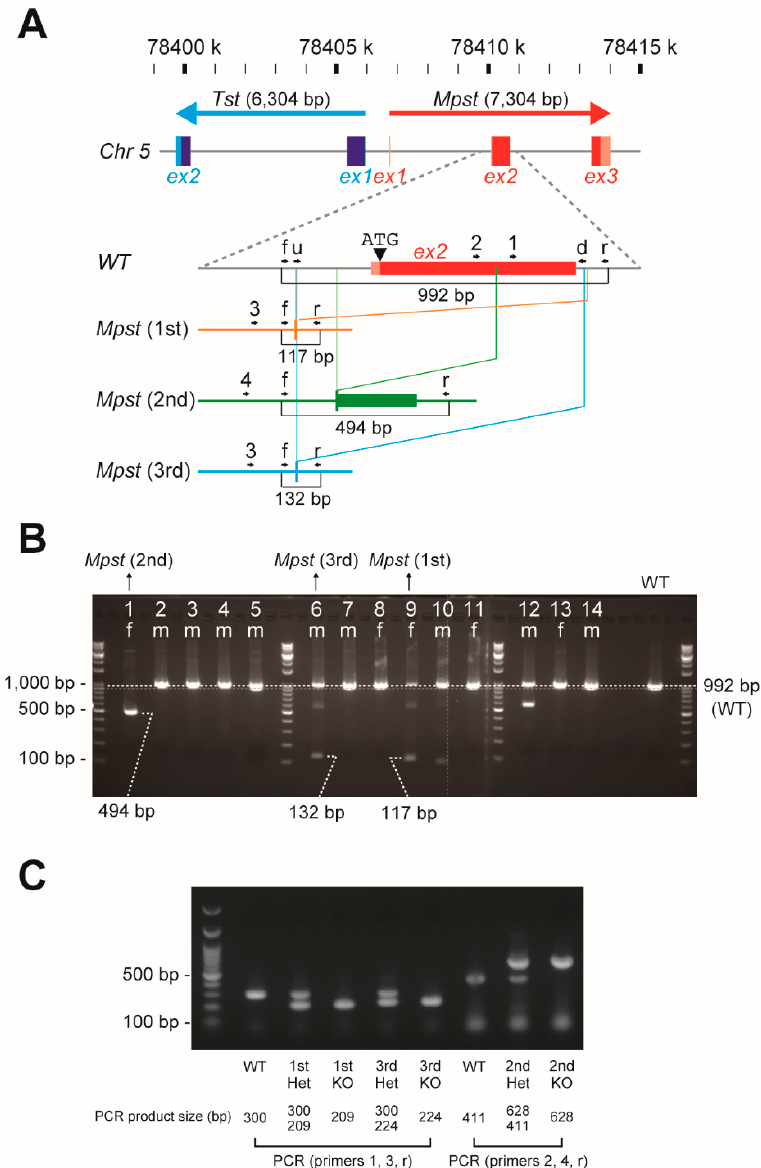
Figure 1. Mpst gene targeting in mice. ( A ) Outline for the Mpst gene deletion by CRISPR/Cas9 and production of 3 mutants. The 7304 bp mouse Mpst gene consists of 3 exons and is located proximal to its homolog Tst gene. The upstream (u) and downstream (d) crRNAs were designed to delete exon 2 which contains the start ATG codon and 67% of the entire open reading frame. Three independent mouse lines (1st, 2nd, and 3rd) were established. ( B ) Initial screening of 1st–3rd mouse lines from 14 independent mice (9 males and 5 females) that originated from individual fertilized zygotes electroporated with Cas9 protein, tracrRNA and crRNAs (u and d). PCR with forward (f) and reverse (r) primers detected the deletion of Mpst exon 2 in the 1st–3rd lines. ( C ) PCR detection of 1st and 3rd-type deletion using 1, 3, and r primers and 2nd-type deletion using 2, 4, and r primers from tail DNAs of wild-type (WT), Mpst-heterozygous (Het), and Mpst-homozygous (KO) mutant mice.